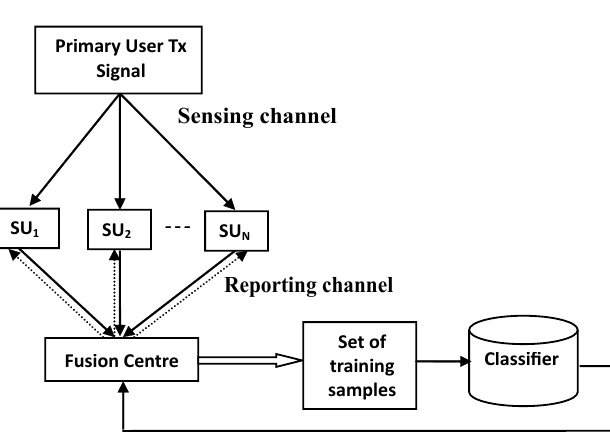
Figure 2. Working model of proposed CSS